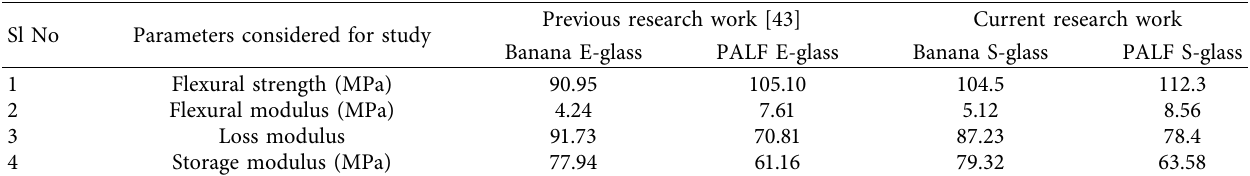
Table 3: Comparison of previous and current research work at 40% fiber volume and 30cm fiber